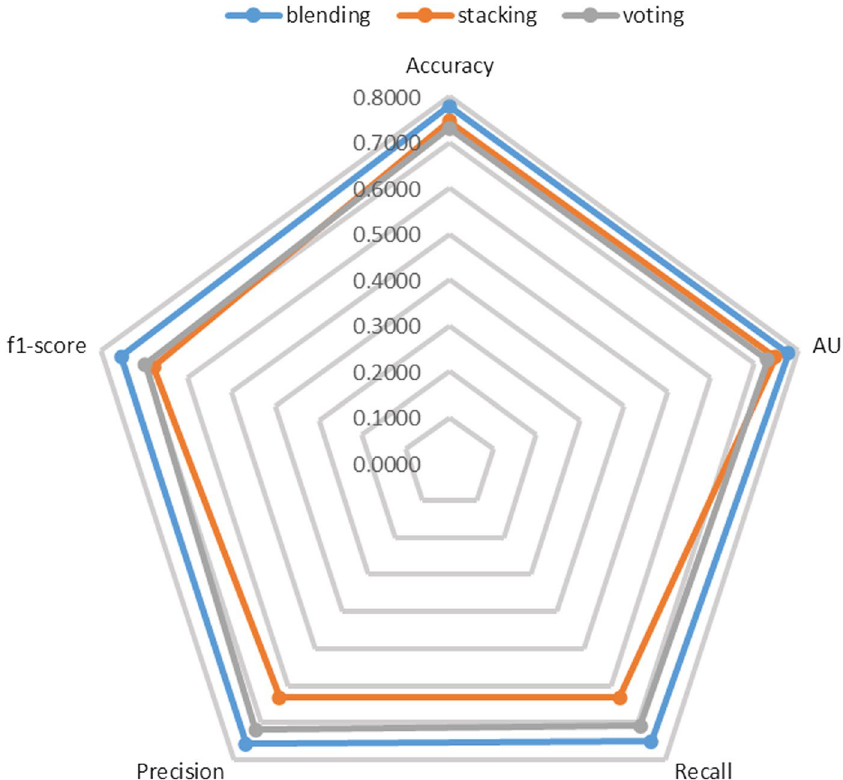
Fig. 7 Radar map showing a comparative analysis of differ- ent